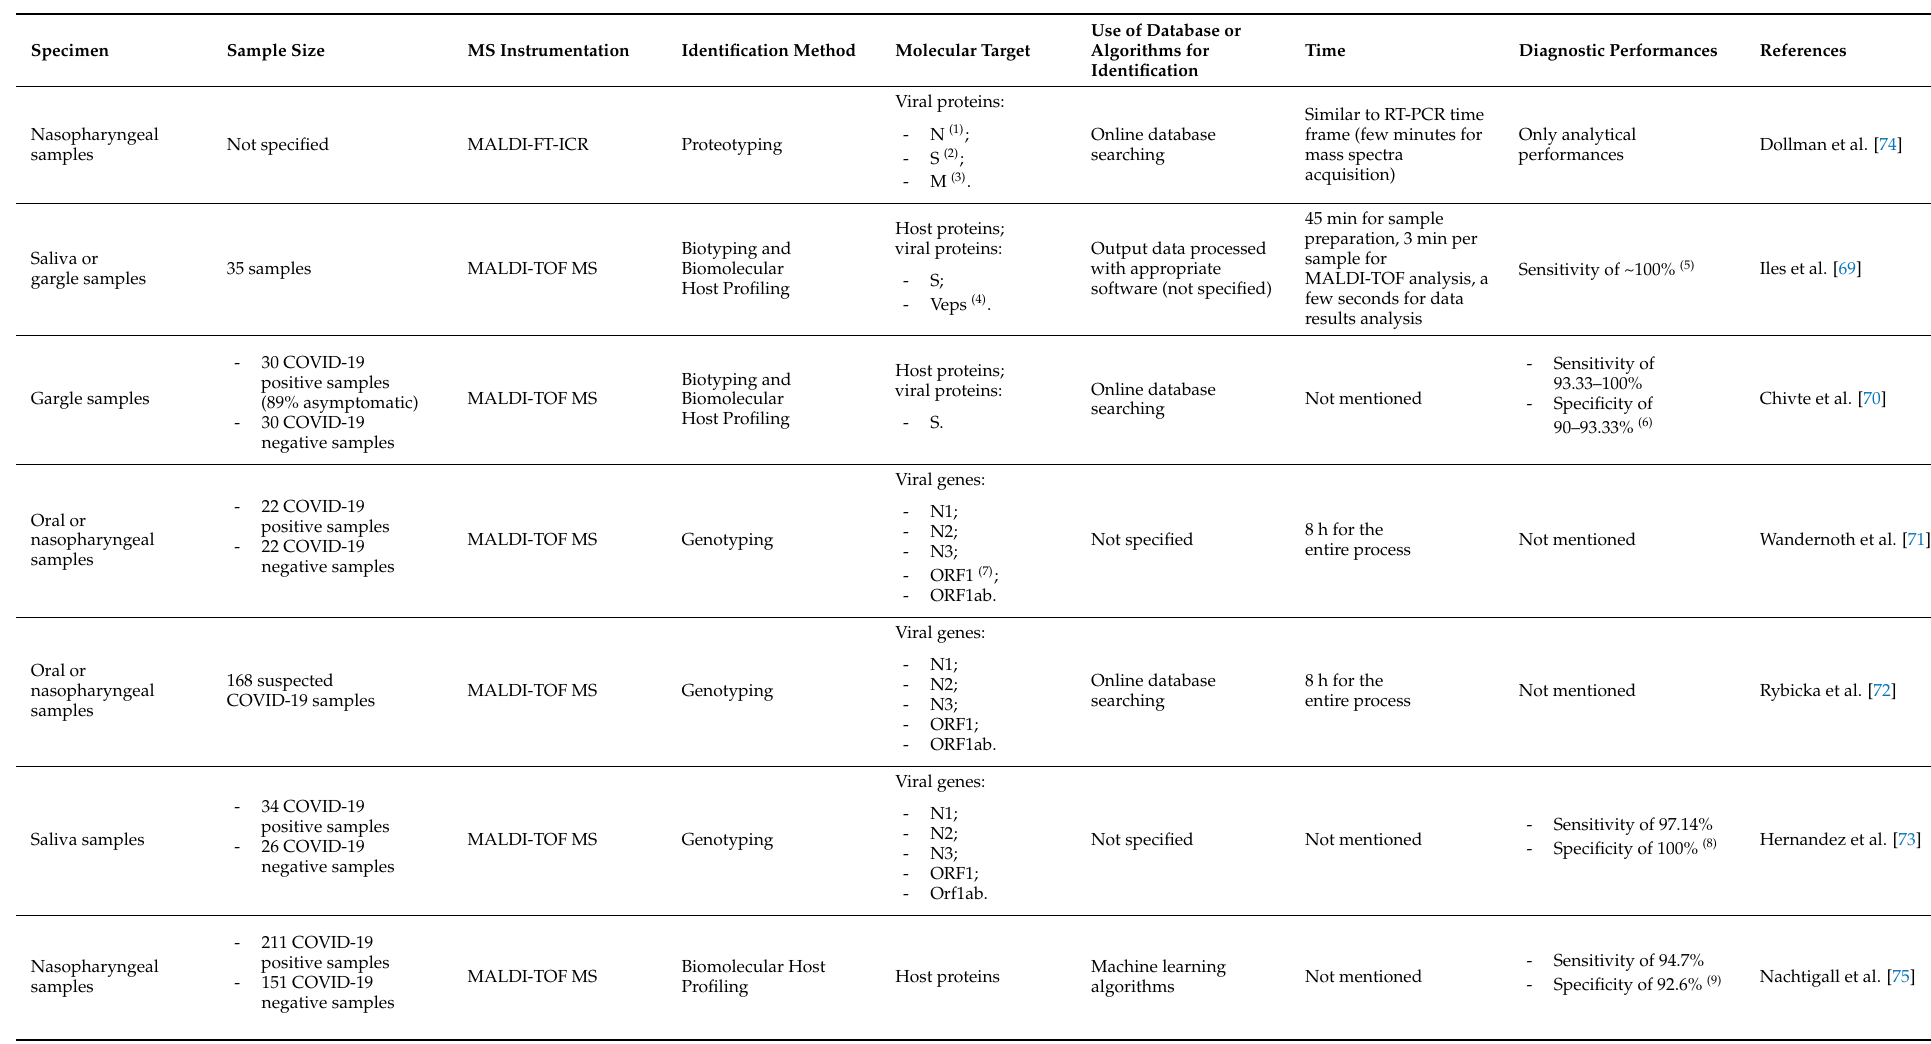
Table 1. MALDI-MS-based SARS-CoV-2 detection studies: specimen, experimental strategy, target molecules, and diagnostic